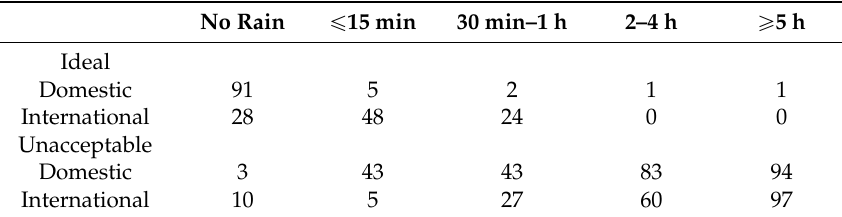
Table 1. Ideal and unacceptable daily rain conditions (% of respondents).